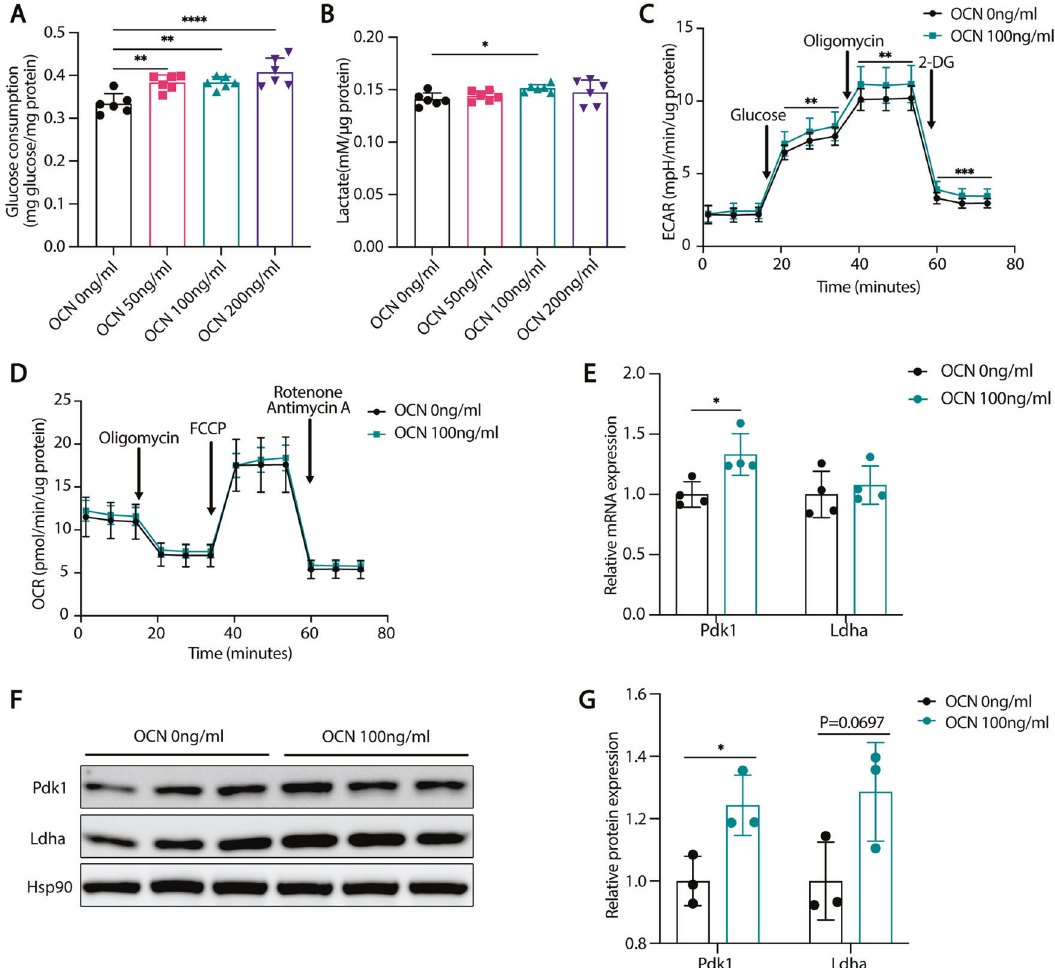
Fig. 5 OCN enhanced glycolysis in astrocytes. A Glucose consumption (normalized to total protein) of C8D1A cells treated with vehicle or different concentrations of OCN. B Lactate production (normalized to total protein) of C8D1A cells treated with vehicle or different concentrations of OCN. C , D Oxygen consumption rate (OCR) and extracellular acidi fi cation rate (ECAR) of C8D1A cells treated with vehicle or 100 ng/ml of OCN. Results are normalized to total protein. E qPCR analysis of mRNA levels of glycolytic enzymes of C8D1A cells treated with vehicle or 100 ng/ml of OCN. F , G Protein levels of glycolytic enzymes of C8D1A cells treated with vehicle or 100 ng/ml of OCN. (Data are presented as mean ±